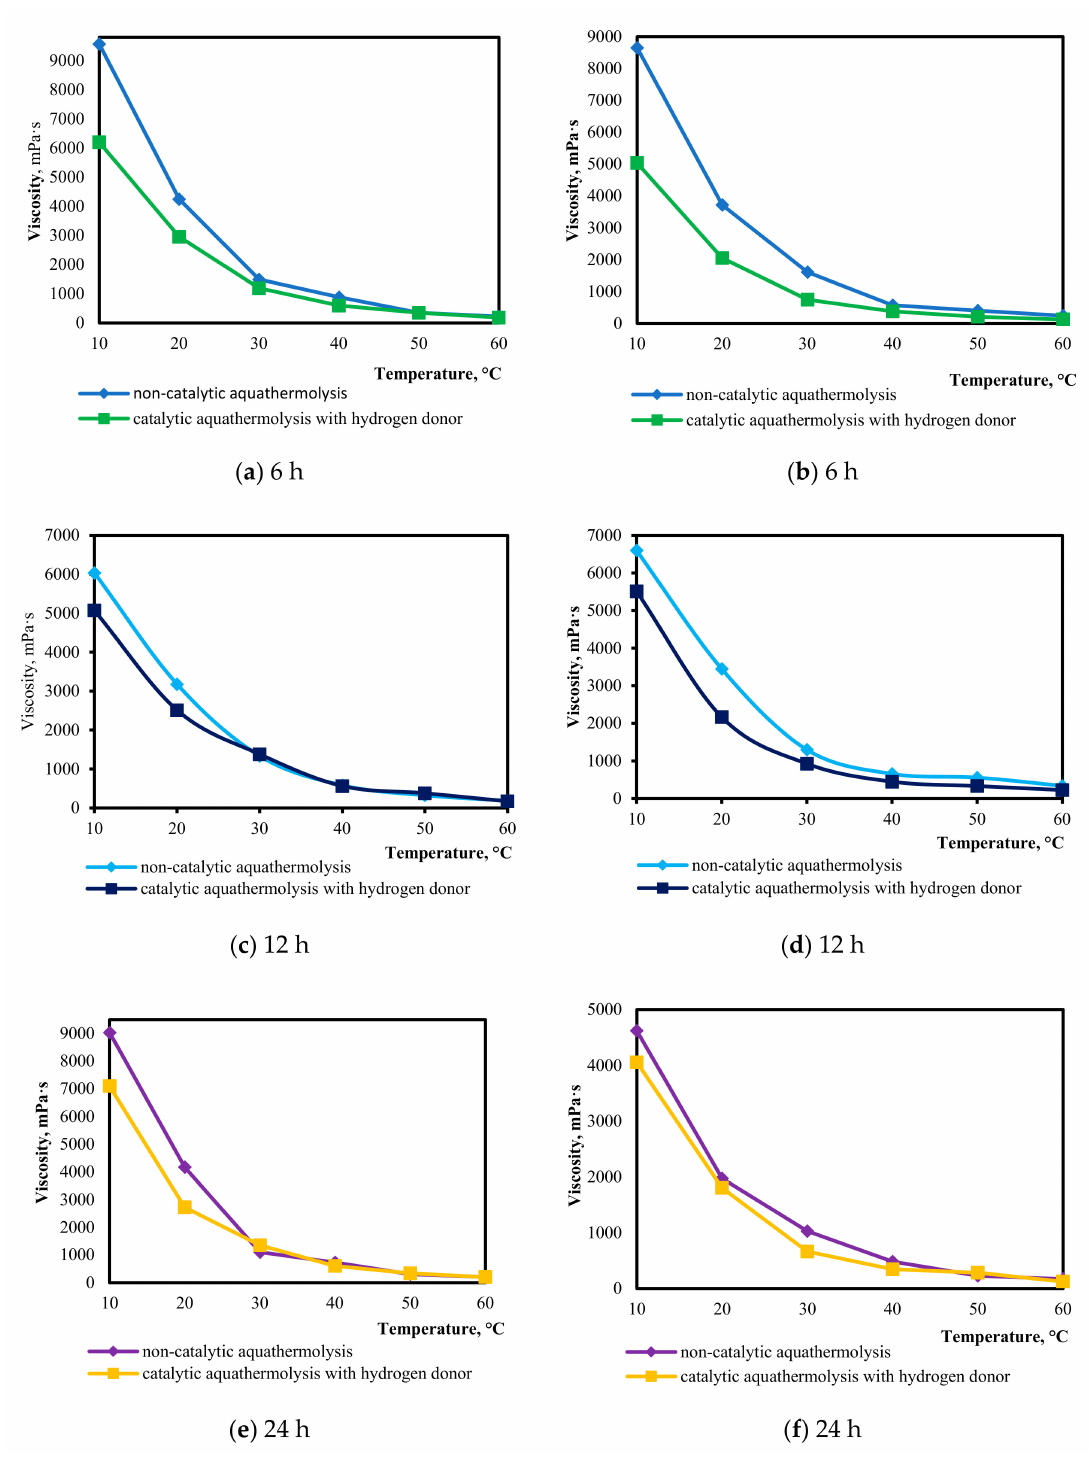
Figure 2. Viscosity of non-catalytic and catalytic aquathermolysis products at 6 ( a ), 12 ( c ), and 24 h ( e ) (temperature 250 ◦ C); and at 6 ( b ), 12 ( d ), and 24 h ( f ) (temperature 300 ◦